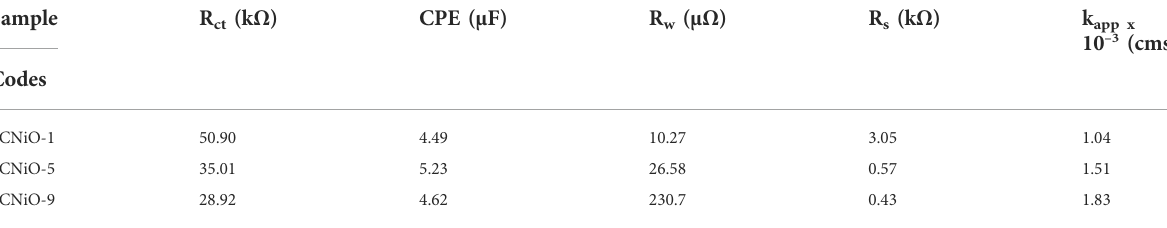
TABLE 1 Data derived from equivalent circuit simulations of EIS spectra.